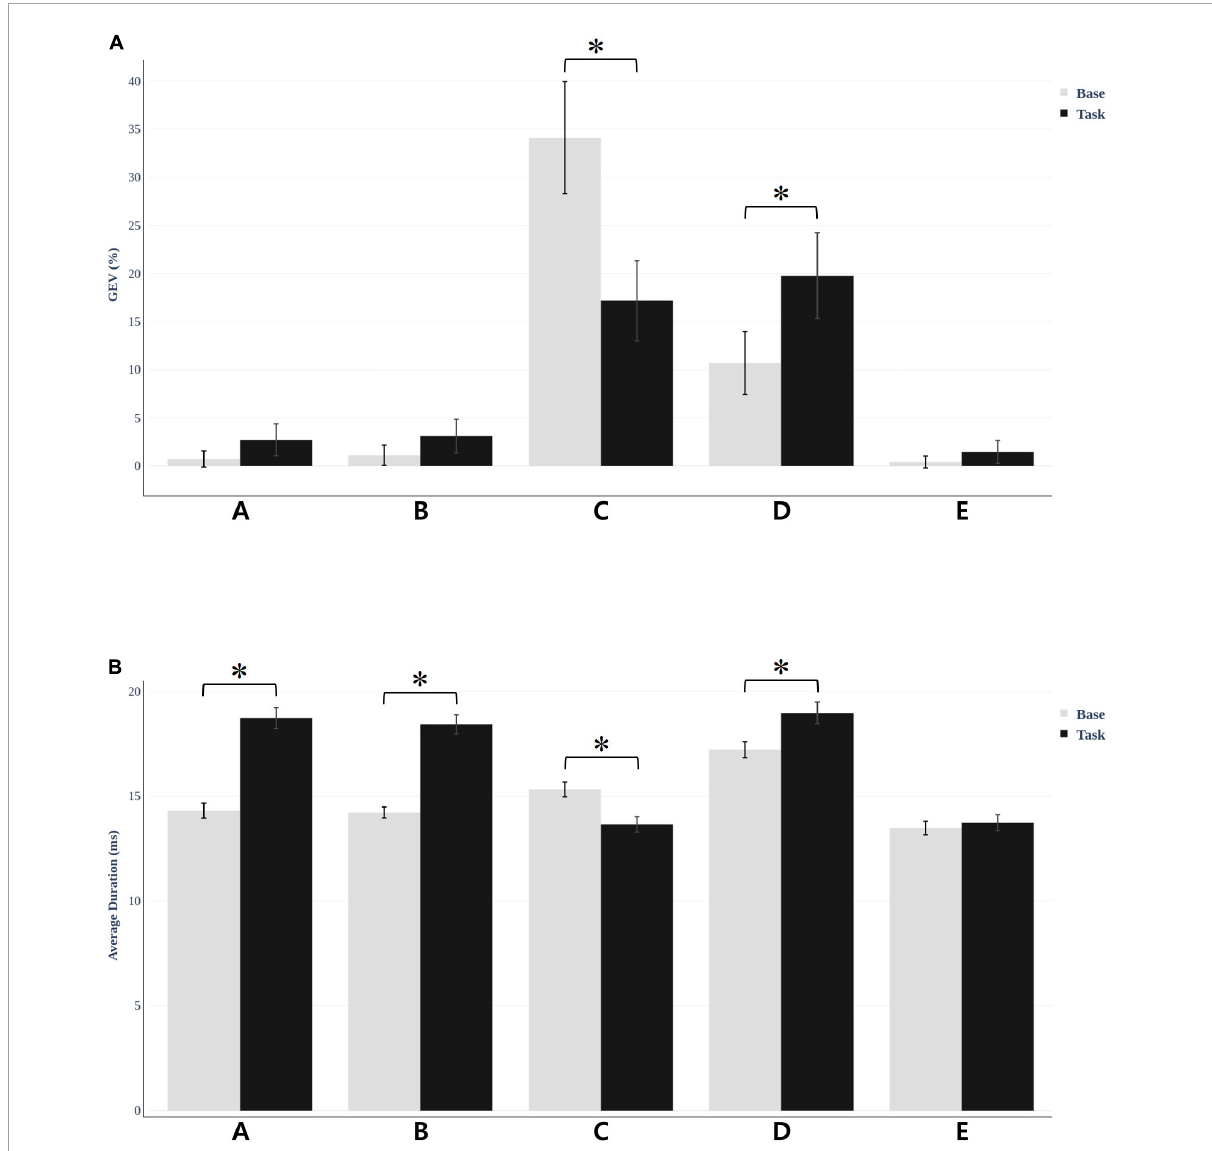
FIGURE4 Microstate global explained variance (GEV) and average duration was different for each condition. (A) For resting vs. task condition, microstate C decreased ( t = − 6.156, * p < 0.001) and D increased ( t = − 8.53, * p < 0.001) in GEV, which was statistically significant. (B) The average duration of the microstates under the two conditions. The results were significant in all microstates except